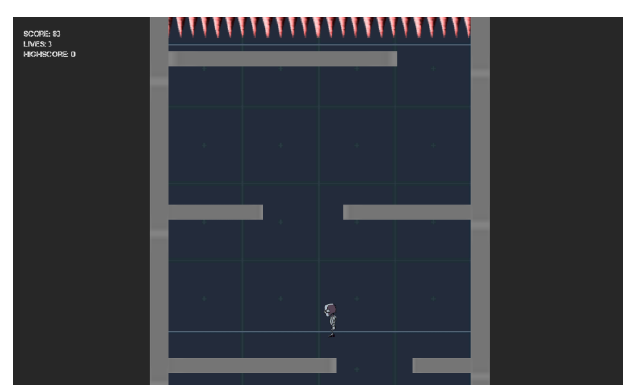
Figure 1. The first level of Drop. The goal of the game was to survive by not hitting the walls for as long as possible by moving the character left and right through the holes with the bottom of the screen moving upwards at an increasing